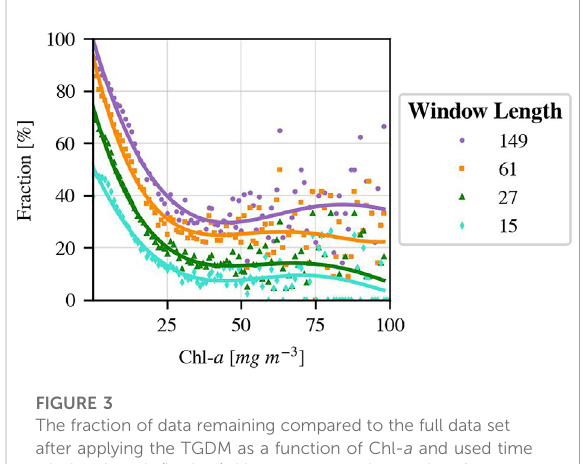
FIGURE 3 The fraction of data remaining compared to the full data set after applying the TGDM as a function of Chl- a and used time window length (in days). Lines represent the results of polynomial fi ts.